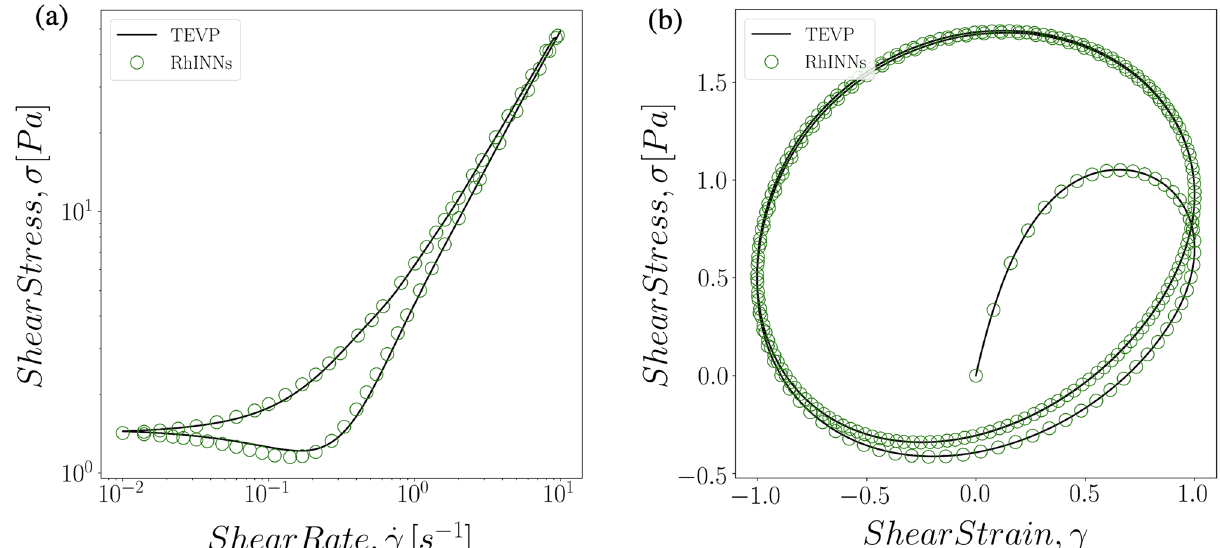
Figure 5. Direct RhINNs solution of a TEVP constitutive equation with two different flow protocols: (a) ramp function with the deformation rate starting from 10 [1/s] and linearly decaying to 0.01 [1/s] over 50 s, followed by increases to the initial value over the same period of time. And (b) Large Amplitude Oscillatory Shear (LAOS) flow with unit amplitude and frequency of ω = 0.2 . For both protocols the model parameters are: G = 5.5 [ Pa ] , σ y = 1 [ Pa ] , η s = 5 [ Pa s ] , η p = 0.5 [ Pa . s ] , k + = 0.1 [ 1 / s ] , k − = 0.3